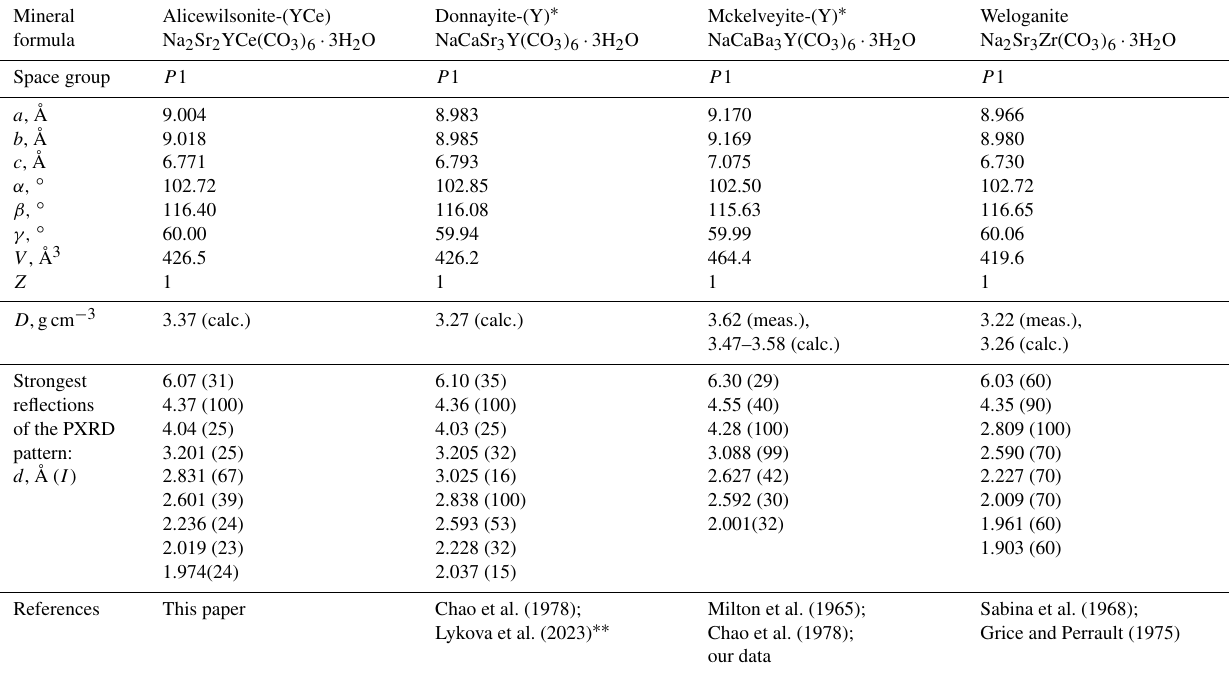
Table 6. Comparative data for alicewilsonite-(YCe) and related mckelveyite group minerals.